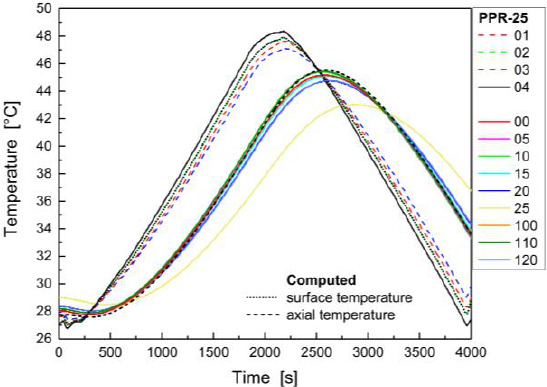
Figure 21. Time-history of measured temperatures and computed surface and axial temperatures (measurement B — temperature increase in climate chamber by 25 °C/probe 1).